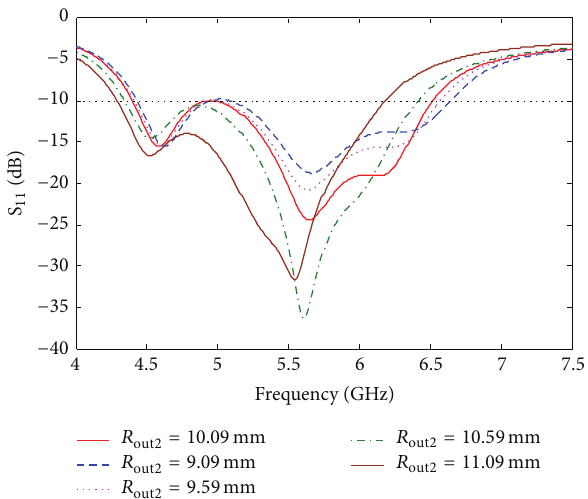
Figure 8: Frequency behavior of the magnitude of the reflection coefficients as a function of the outer diameter 𝑅 = 21.79 mm, 𝑃 𝑥 = 3.85 mm, 𝑅